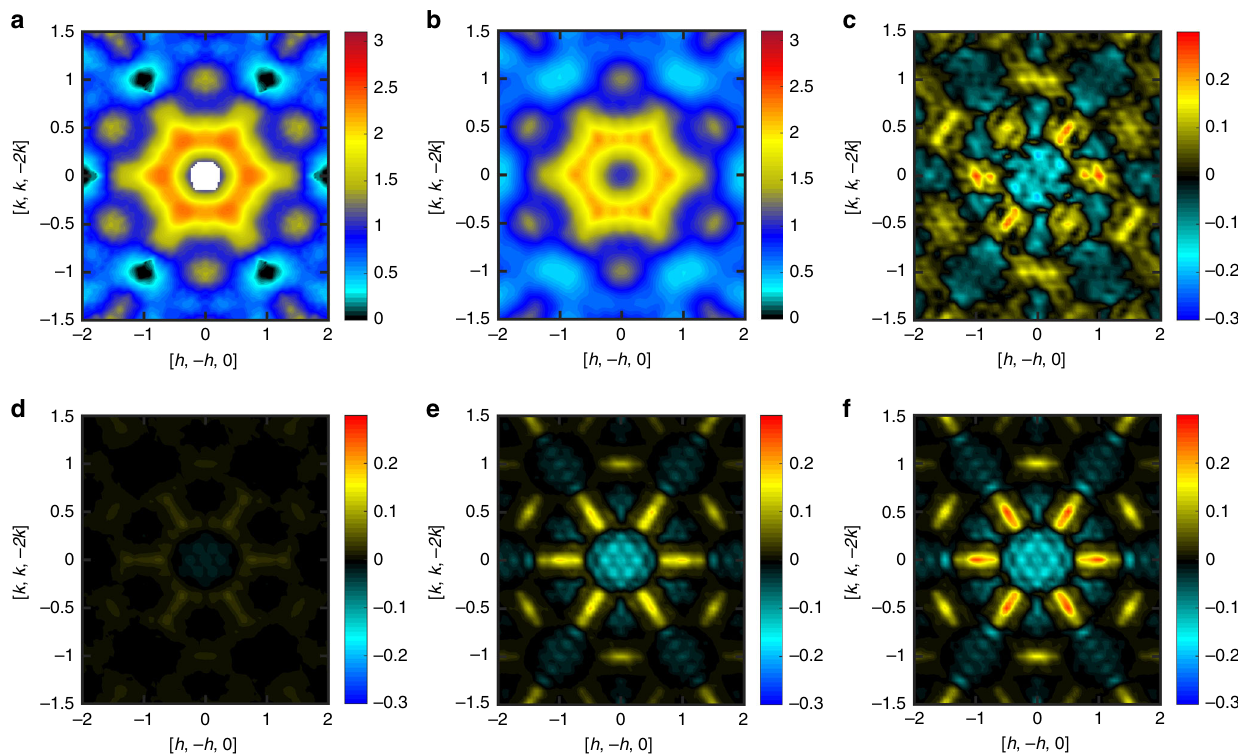
Fig. 3 Effect of latent space variables on structure factor. a Experimental scattering data S exp ( Q ) in the high symmetry plane. Dark patches indicate zero signal due to nuclear Bragg peaks. b The corresponding simulated data for the optimal model Hamiltonian. c Change in the simulated structure factor Δ S sim when the J 2 coupling is perturbed from 0.16 K to − 0.18 K. The relatively weak response Δ S sim to a perturbation in J 2 of ±0.05 J 1 illustrates the challenge in inferring the correct spin Hamiltonian. d – f The change in the autoencoder output when 1, 6, and 12 latent space components, respectively, are updated to account for the perturbation on J 2 (see main text for